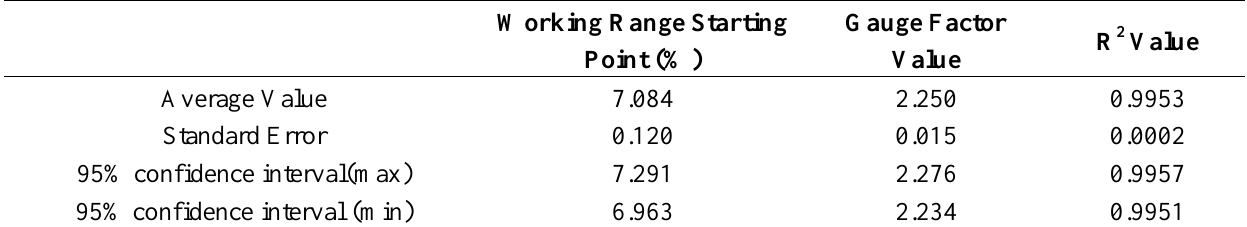
Table 11. Statistical results of samples realised with four conductive courses.